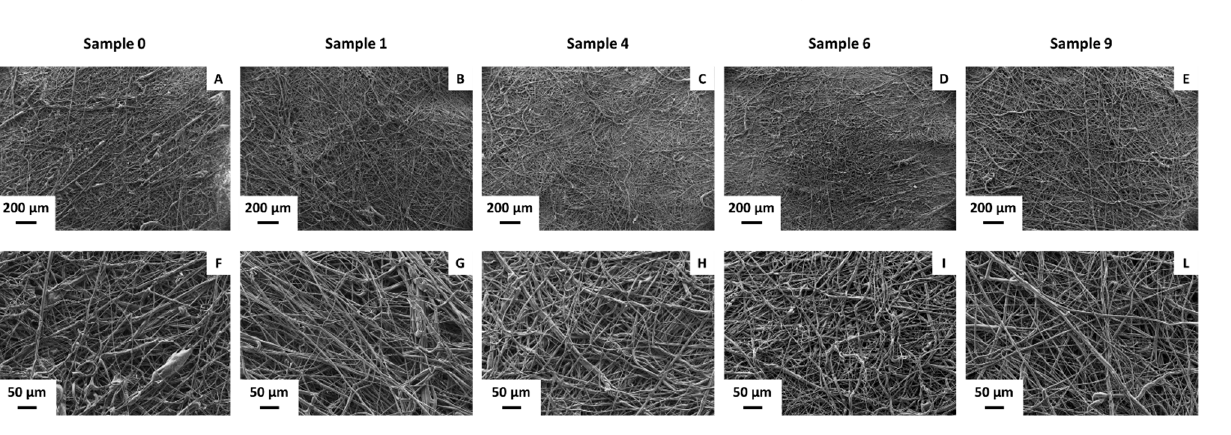
Figure 3. FESEM images of the selective layer of the gold standard (sample 0) and the 1, 4, 6, and 9 face mask samples at 150× ( A – E ) and 500× ( F – L ) magnifications.